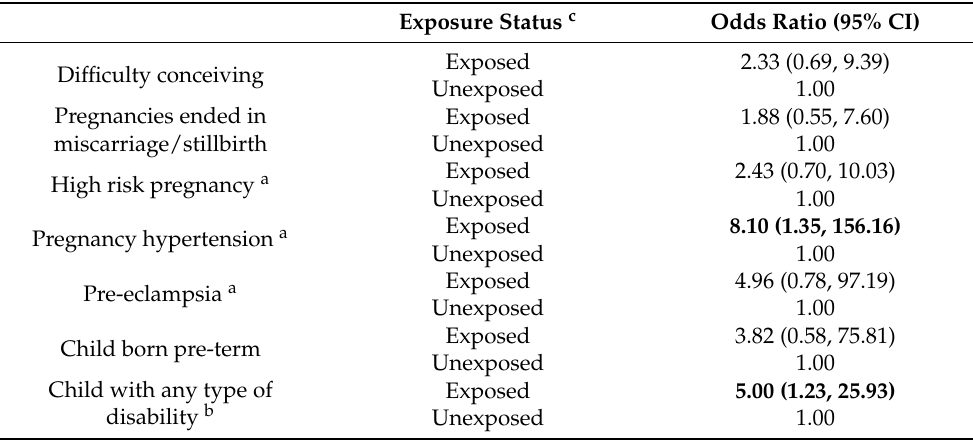
Table 3. Association between using pesticide cream/liquid on the skin during deployment and the odds of adverse reproductive and children’s health outcomes among women deployed to the Persian